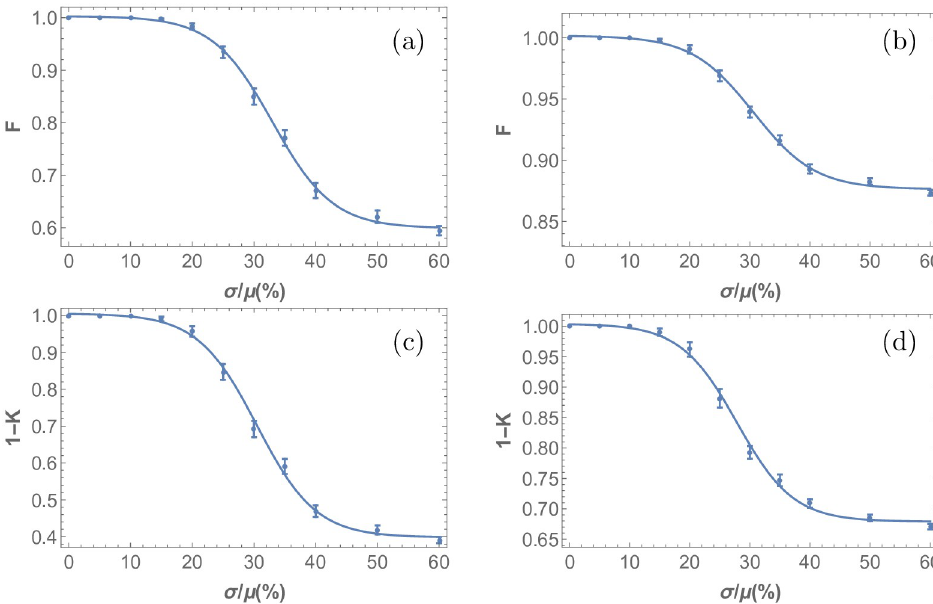
Fig 9. Probability distance measures applied to analyze response to stochasticity in R8 cell point pattern formation. (a)-(b) are generated using the fidelity, F, and (c)-(d) using the Kolmogorov distance, K, for nearest neighbor distances and angles respectively. Stochasticity was introduced in the model through drawing the parameter D u and D s in the differential equations Eqs 1–4 from a normal distribution with varying standard deviation, σ , and mean value, μ . The simulation results were compiled, and nearest R8 cell neighbor angle and distance distributions were obtained. Kolmogorov and fidelity of the resulting distributions where computed with reference to the perfect pattern case. Here, a value of 1 corresponds to a perfectly ordered pattern, and a value of 0 corresponds to a completely irregular pattern. This figure illustrates that the functional form is independent of the measure